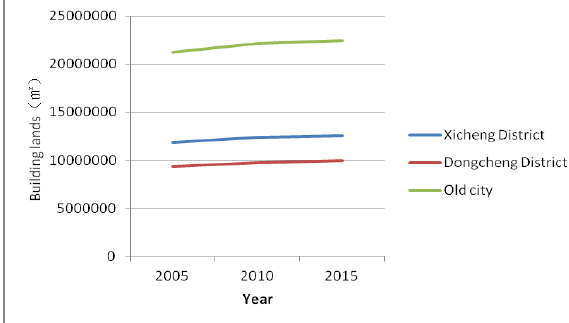
Figure 1. Building lands in old city from 2005 to 2015 with an interval of 5 years